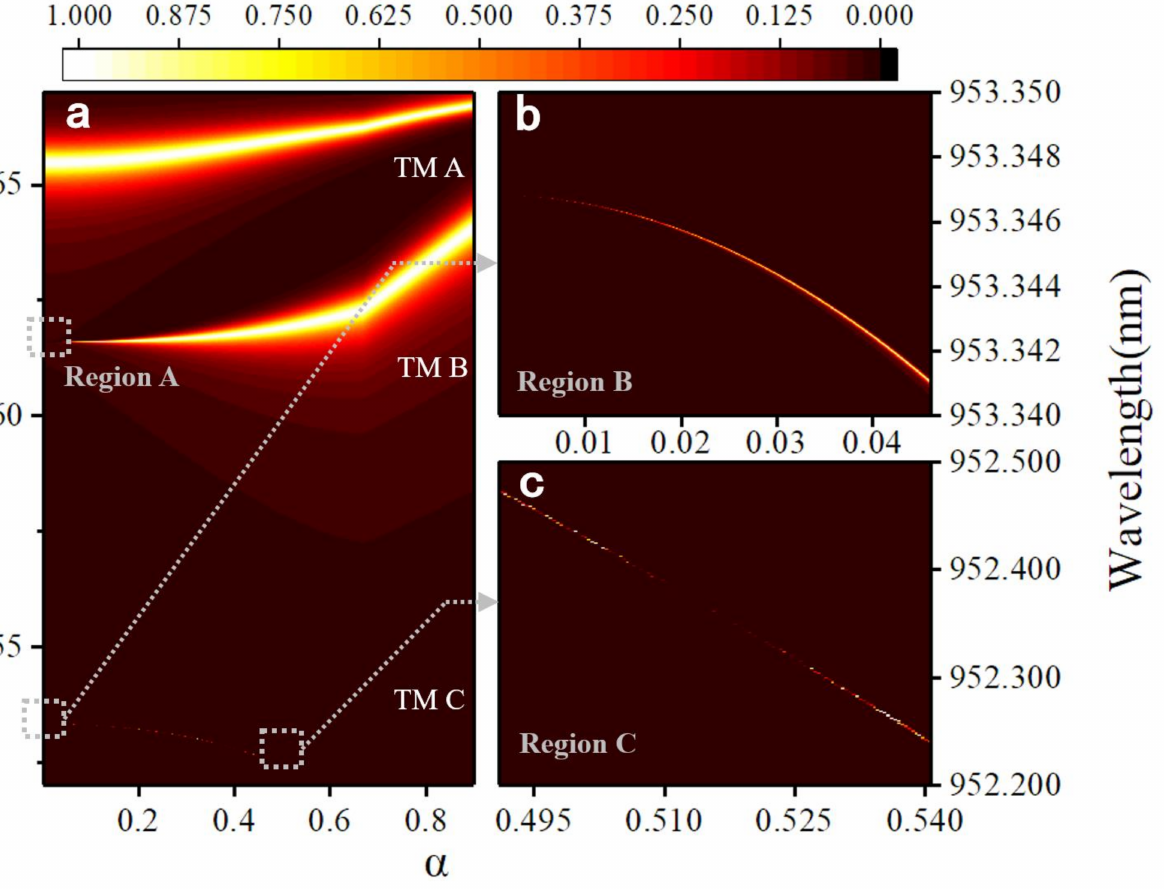
Figure 2. ( a ) The reflection spectrum variation with the asymmetry parameter α and ( b , c ) partial enlarged view when the period is 600 nm. The color represents reflection, from 0 to 1. Regions A, B, and C include a BIC,